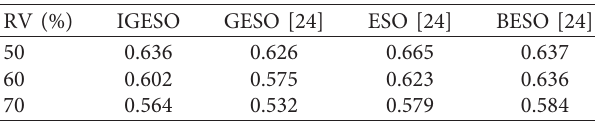
Figure 5: IGESO optimal design for simply supported beam: (a) topology for 50% volume reduction, (b) topology for 60% volume reduction, (c) topology for 70% volume reduction, and (d) PI curve of the whole process. Table 1: Comparison of the results from the four